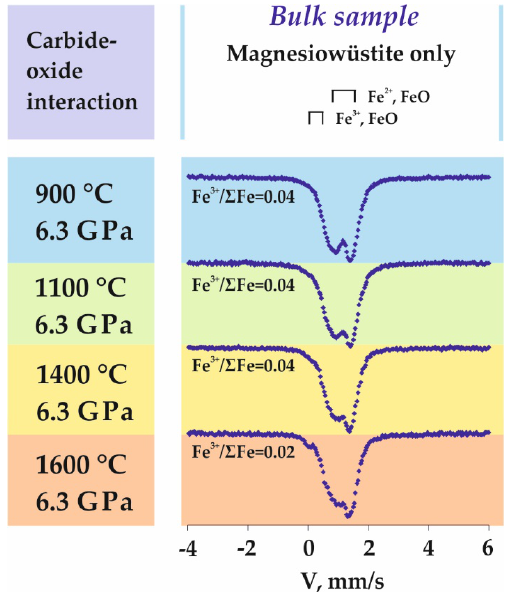
Figure 13. Mössbauer spectra of wüstite produced in the carbide-oxide system. Table 5. Results of the Mössbauer spectroscopy of wüstite and magnesiowüstite formed in the